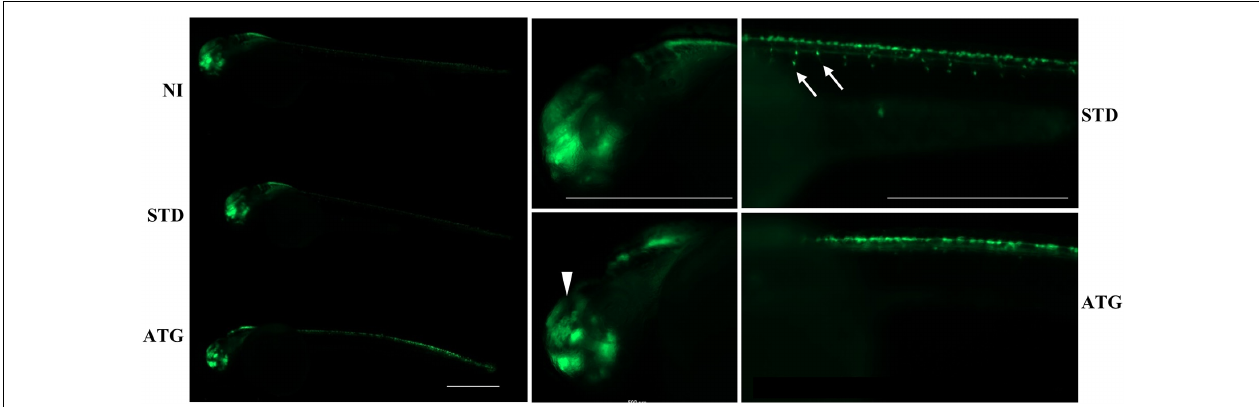
FIGURE 4 | neurog1 -dependent EGFP fluorescence in embryos injected with control (STD) or ATG morpholinos. Lateral views of Tg( neurog1 :EGFP) embryos either injected or not with STD or ATG morpholinos, at 48 hpf, with different magnifications. The arrowhead points to the region in the midbrain (tectum opticum) that shows a clear reduction of the signal in morphants. Arrows point to drg neurons, normally labeled in STD-injected embryos, but not visible in morphants. Size bar = 500 µ m. Experiments were repeated at least three times and altogether more than 120 embryos of each type were viewed.